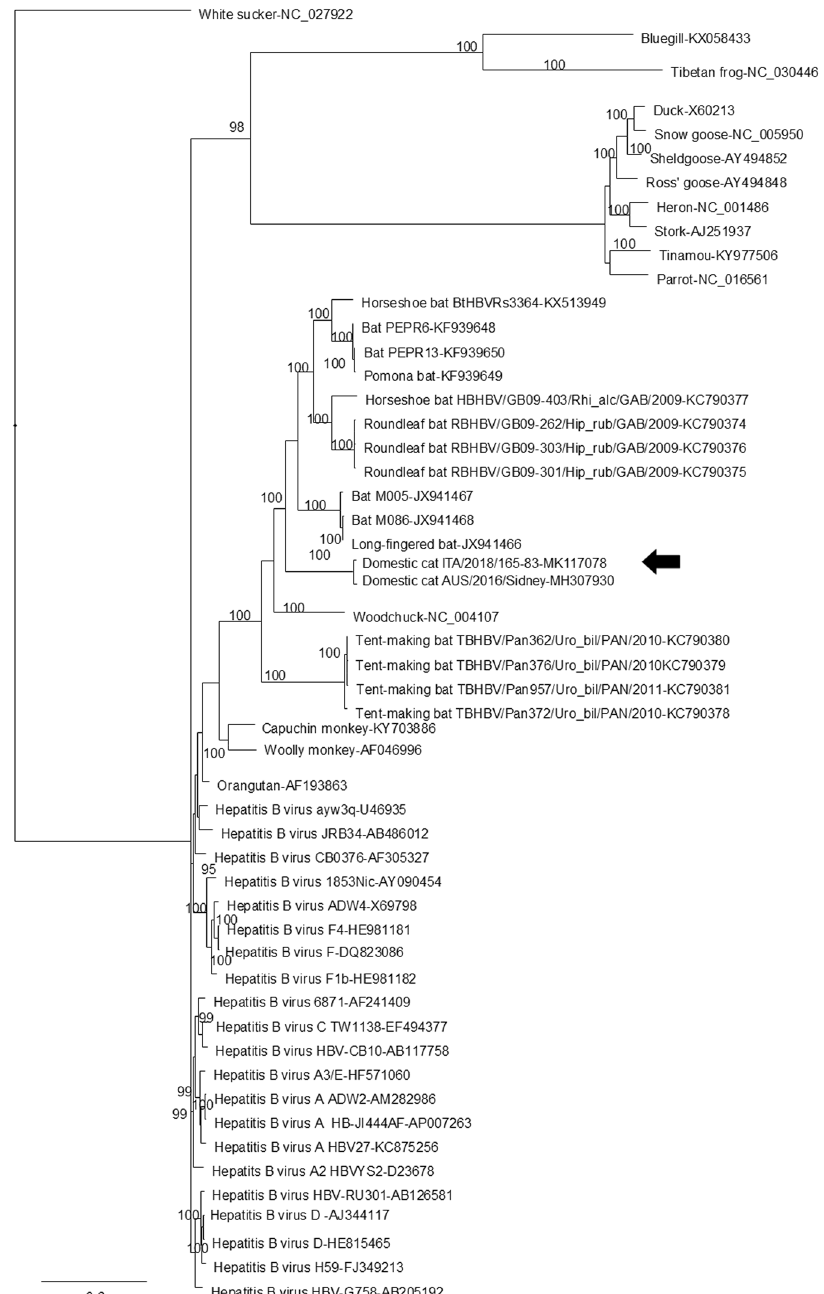
Figure 3. Bayesian phylogenetic tree based on complete genomic sequences of hepadnaviruses retrieved from the Genbank database. Posterior probability values > 95% are shown on the nodes of the tree. Italian feline strain ITA/2018/165-83 (GenBank accession nr. MK117078) is indicated by black arrow. White Sucker hepadnavirus (NC_027922) was used as outgroup. The scale bar indicates the number of nucleotide substitutions per